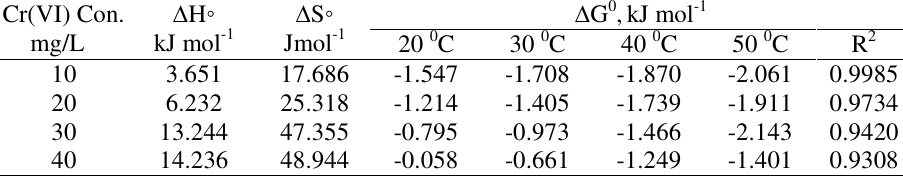
∆ G 0 , kJ mol -1 Cr(VI) Con.